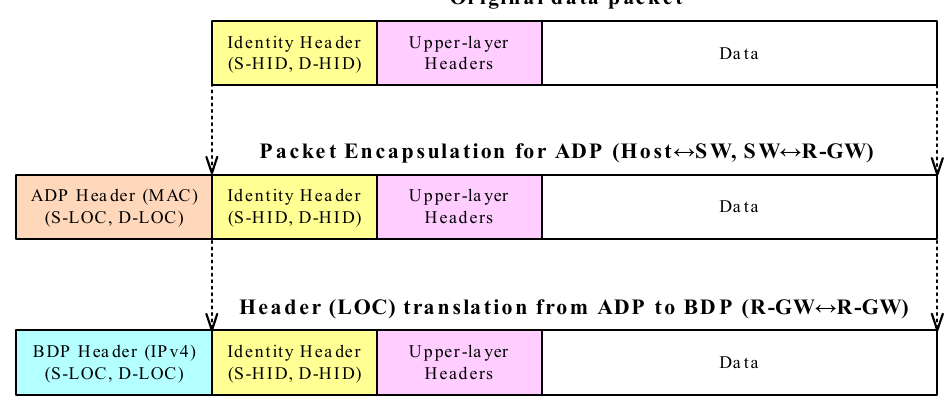
Figure 9. Identity header format.